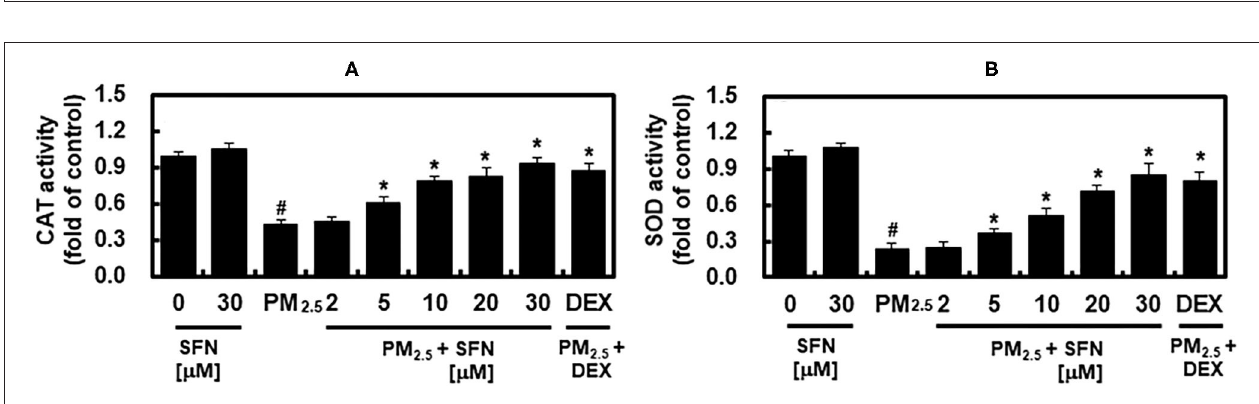
FIGURE 5 | Effects of Sulforaphane (SFN) and PM 2.5 on antioxidant enzyme activities. ARPE-19 cells were treated with the indicated concentrations of SFN or DEX (1 µ M) for 6 after 24h PM 2.5 challenge (100 µ g/mL). After treatment, the activities of (A) catalase (CAT) and (B) superoxide dismutase (SOD) were measured. Values represent mean ± SD of three independent experiments. * p < 0.01 relative to PM-challenged group, one-way ANOVA. # p < 0.01 relative to control, one-way